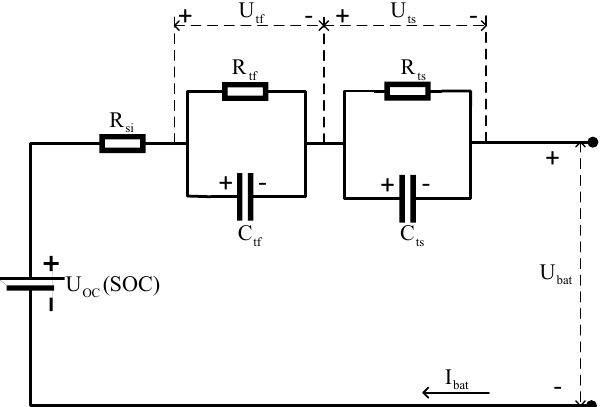
Figure 1. Schematic diagram of the second-order RC equivalent circuit.